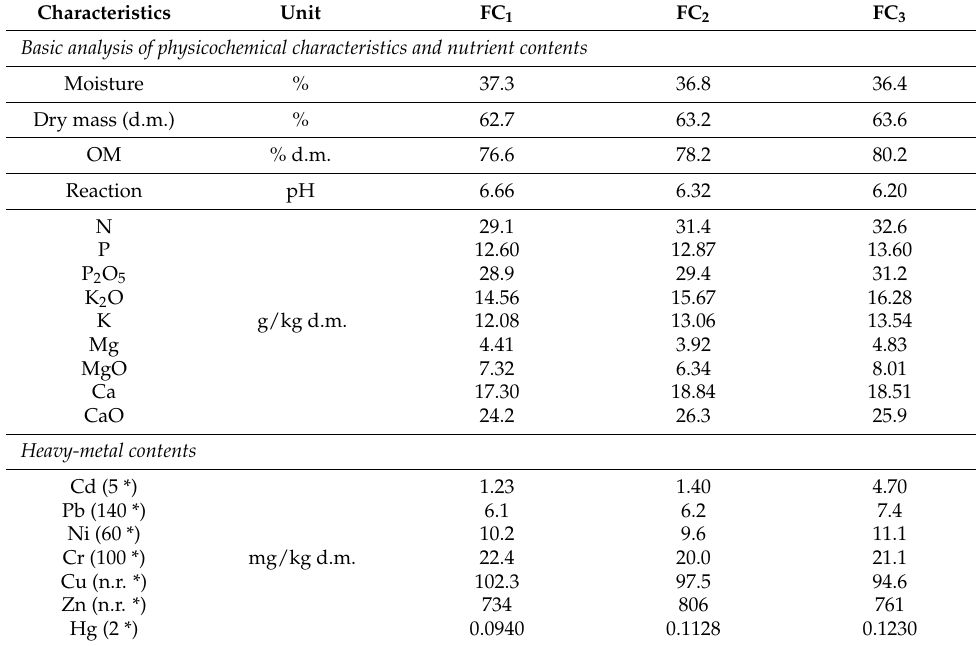
Table 4. Compost